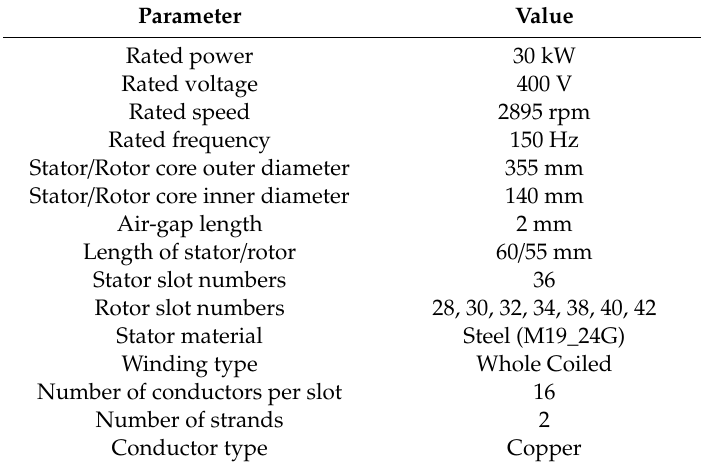
Table 3. General design parameters of Axial Flux Induction Motor